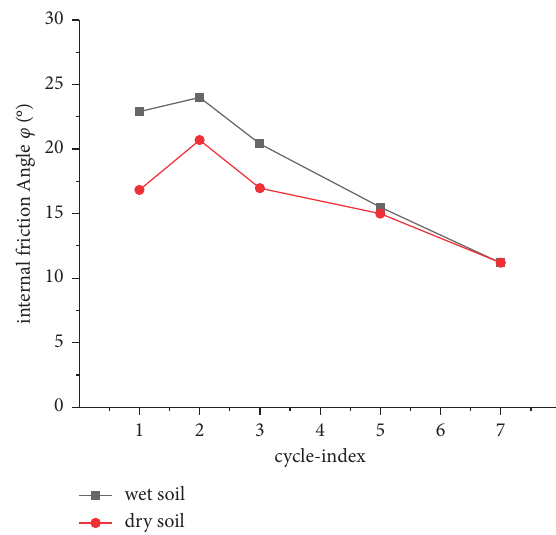
Figure 11: φ -drying-wetting cycle curve.